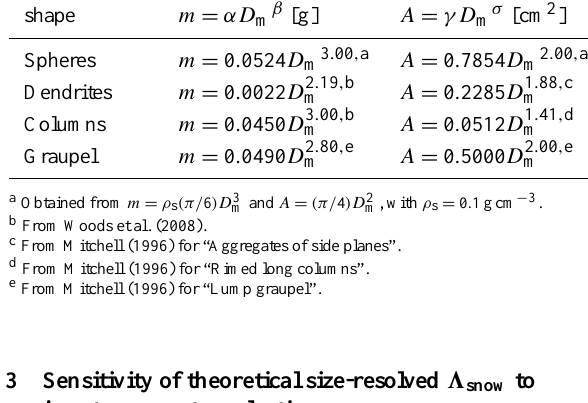
Table 4. Snow-particle shapes considered in this study and their mass and cross-sectional area formulas. D m is the snow crystal maximum diameter (cm). Snow-particle Mass Cross-sectional area shape m = αD m β [g] Spheres Dendrites Columns m = 0 . 0450 D 3 . 00 , b m